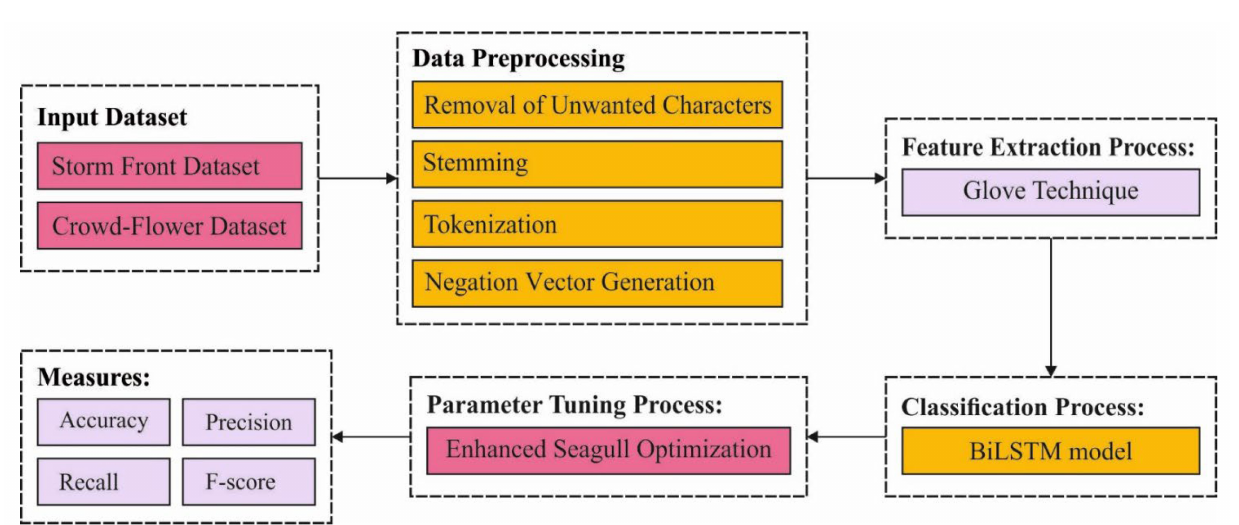
Figure 1. Block diagram of ESGONLP-HSC